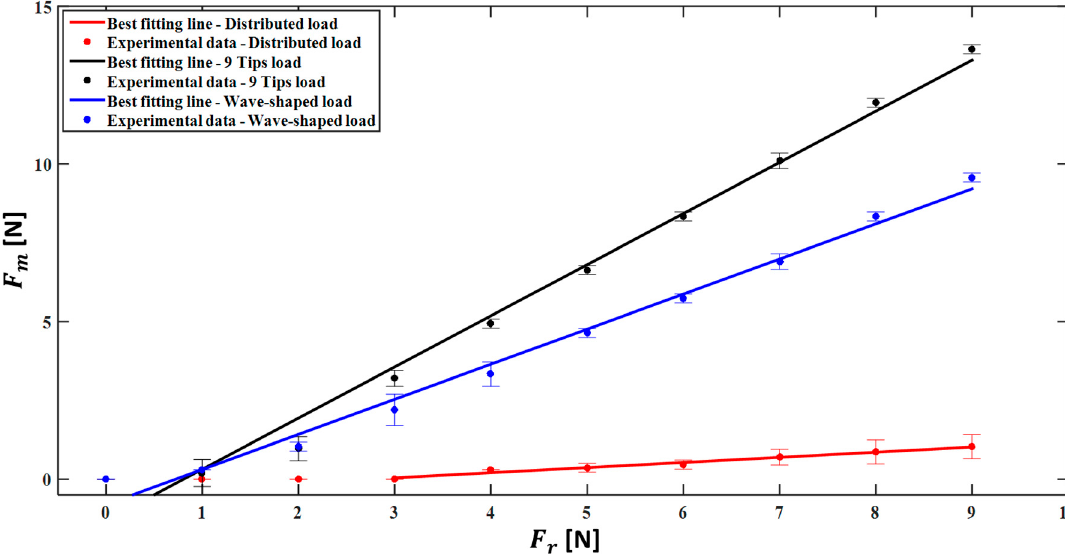
Figure 7. Mean value of force measured ± expanded uncertainty, for the sensor S2004–060 and each reference load applied. The best fitting line for each examined loading condition is also shown.